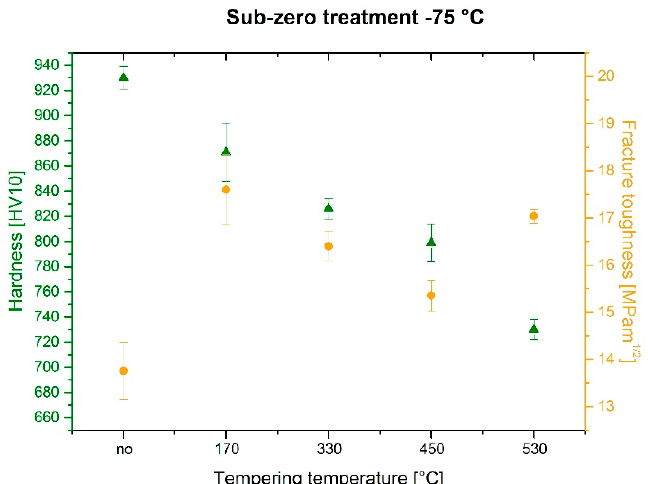
Figure 10. Fracture toughness versus hardness of the Vanadis 6 steel after SZT at − 75 °C for 17 h, and subsequent tempering.